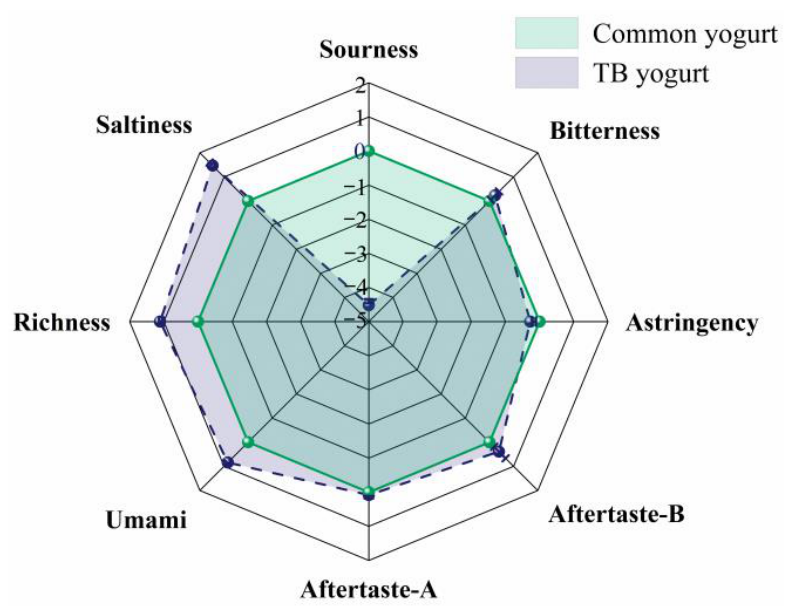
Figure 4. Spider plot for electronic tongue sensory score of common yogurt and TB yogurt.